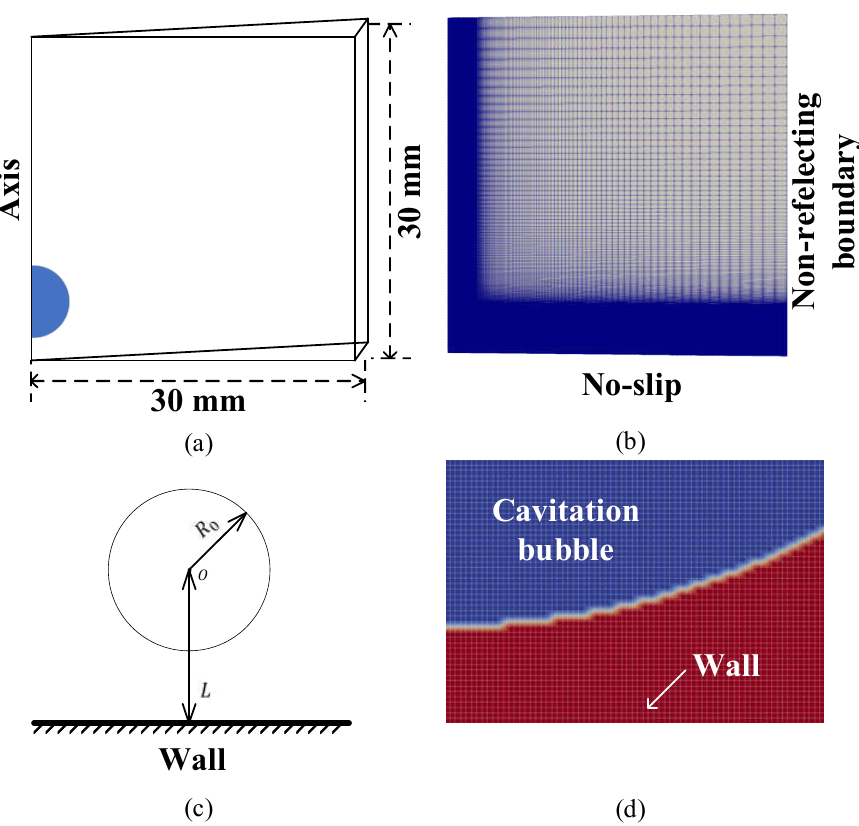
Figure 3. ( a ) Sectional view of the bubble–wall system. ( b ) Schematic diagram of the bubble collapse near a rigid wall. ( c ) Boundary conditions and mesh information. (d) mesh details around the bubble.